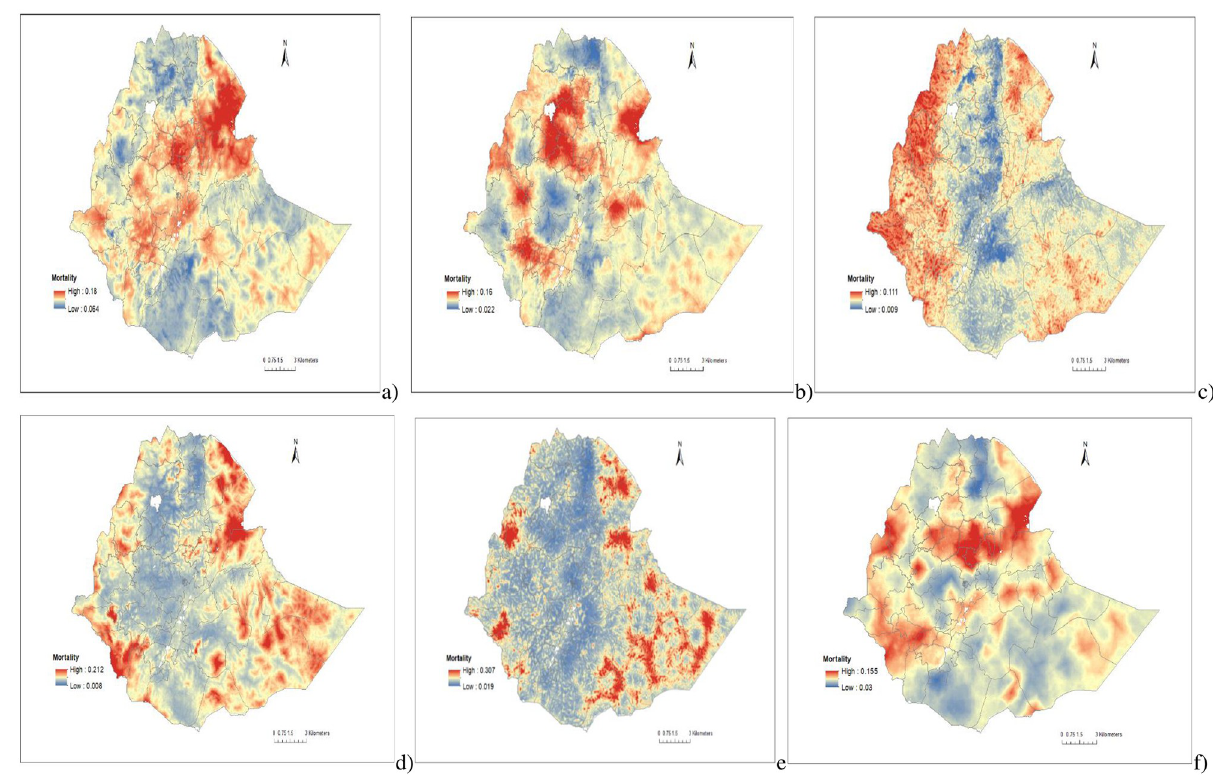
Fig 3. The predicted geospatial map for under-five mortality in Ethiopia: 2000(a), 2005(b), 2011(c), 2016(d), 2019(e) and 2000–2019(f).